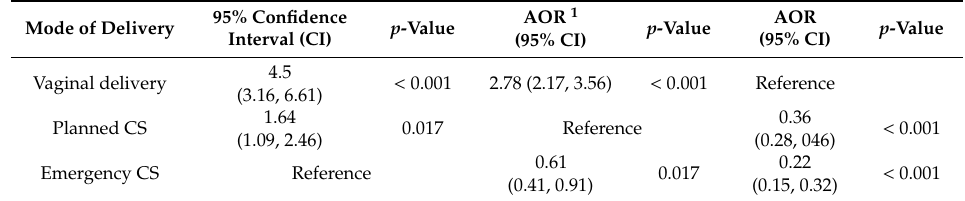
Table 3. Impact of mode of delivery (vaginal delivery, planned CS, and emergency CS) in comparison to each other on an early initiation of breastfeeding using logistic regression